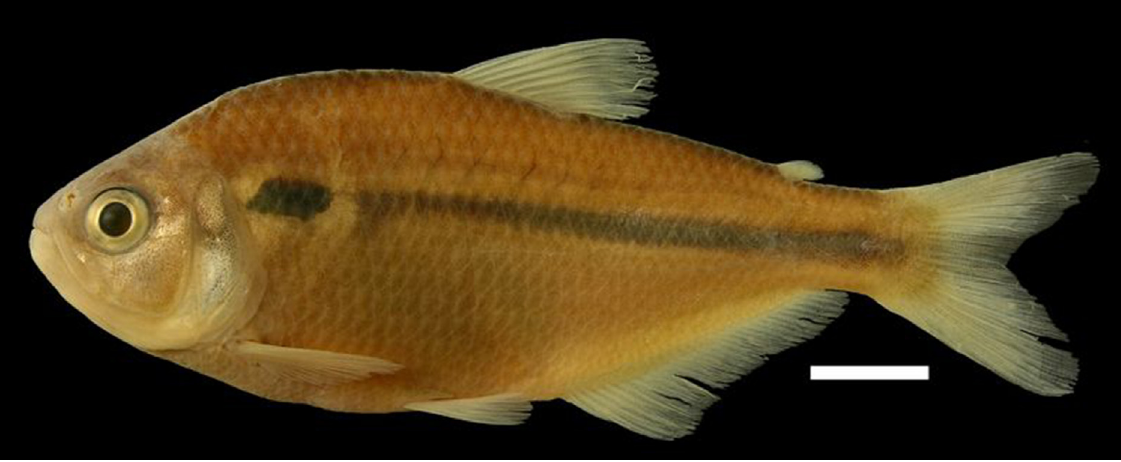
Fig. 11. Astyanax villwocki Zarske & Géry, 1999, 74.7 mm SL, Caquetá River, Colombia (IUQ 3593). Scale bar = 1